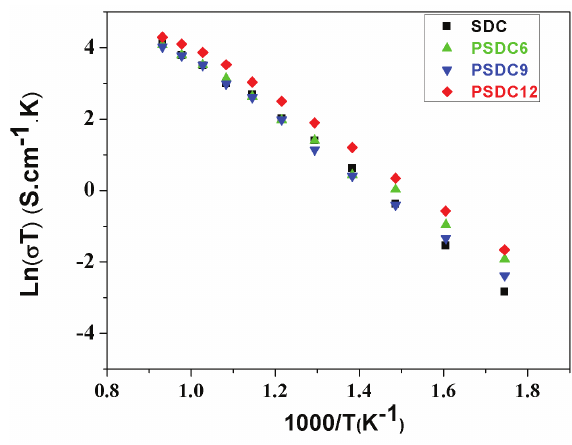
Figure 4: Arrhenius plots for the electrical conductivities of the Ce Sm Pr O 0.80 0.20-x x 2-δ